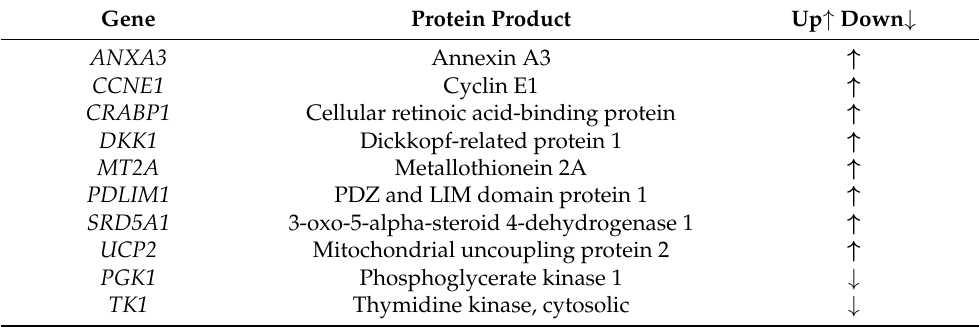
Table 2. Breast carcinogenesis-associated gene signatures in MCF-7 cells submitted to chronic CdCl 2 exposure